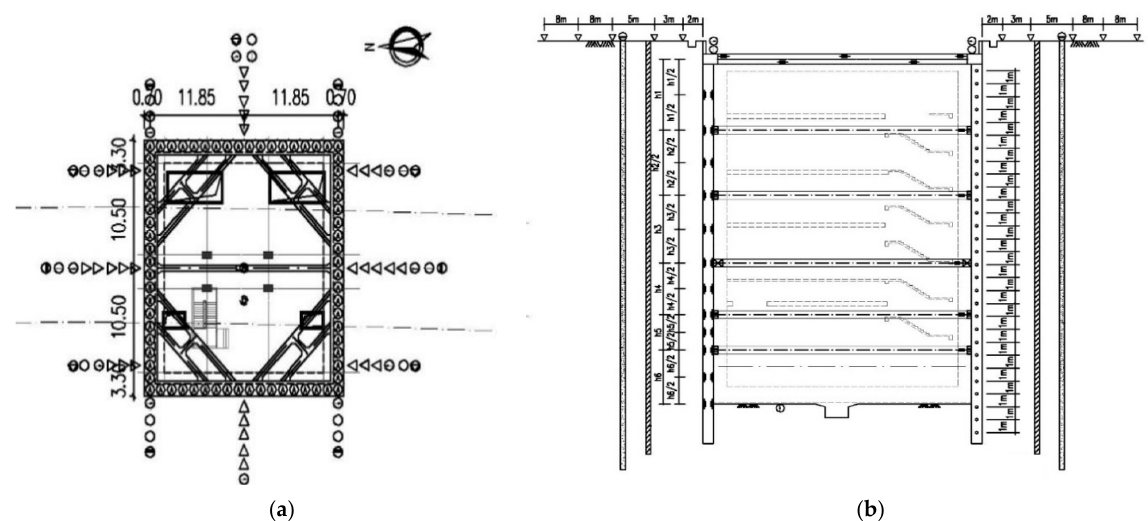
Figure 12. Foundation pit measurement layout plan. ( a ) cross-section from top view; ( b ) section of pit measurement.